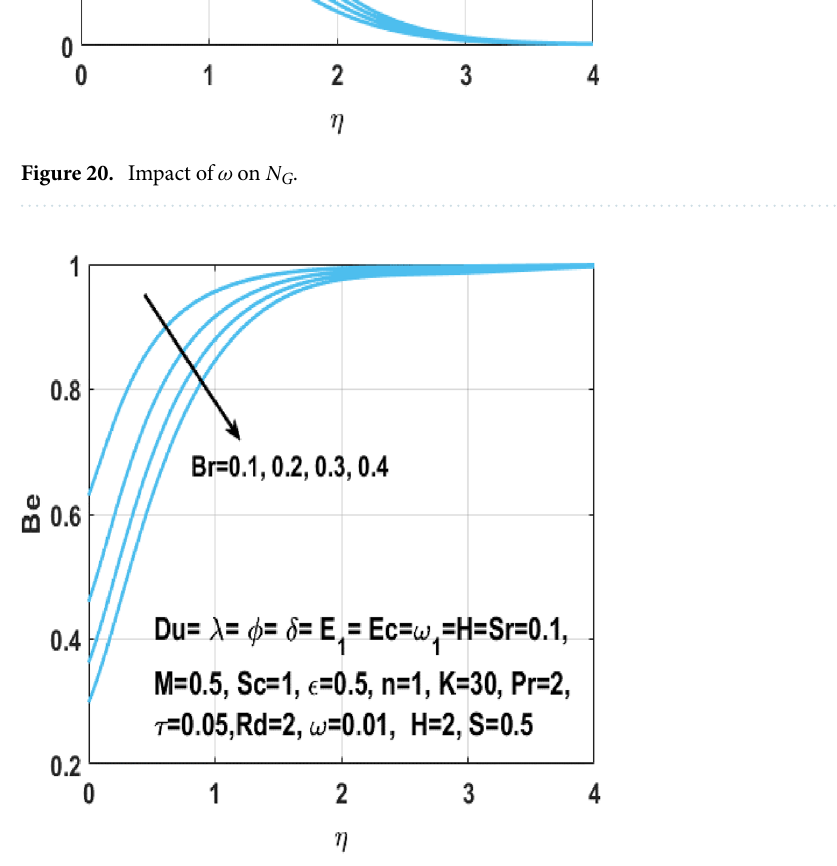
Figure 21. Impact of Br on Be